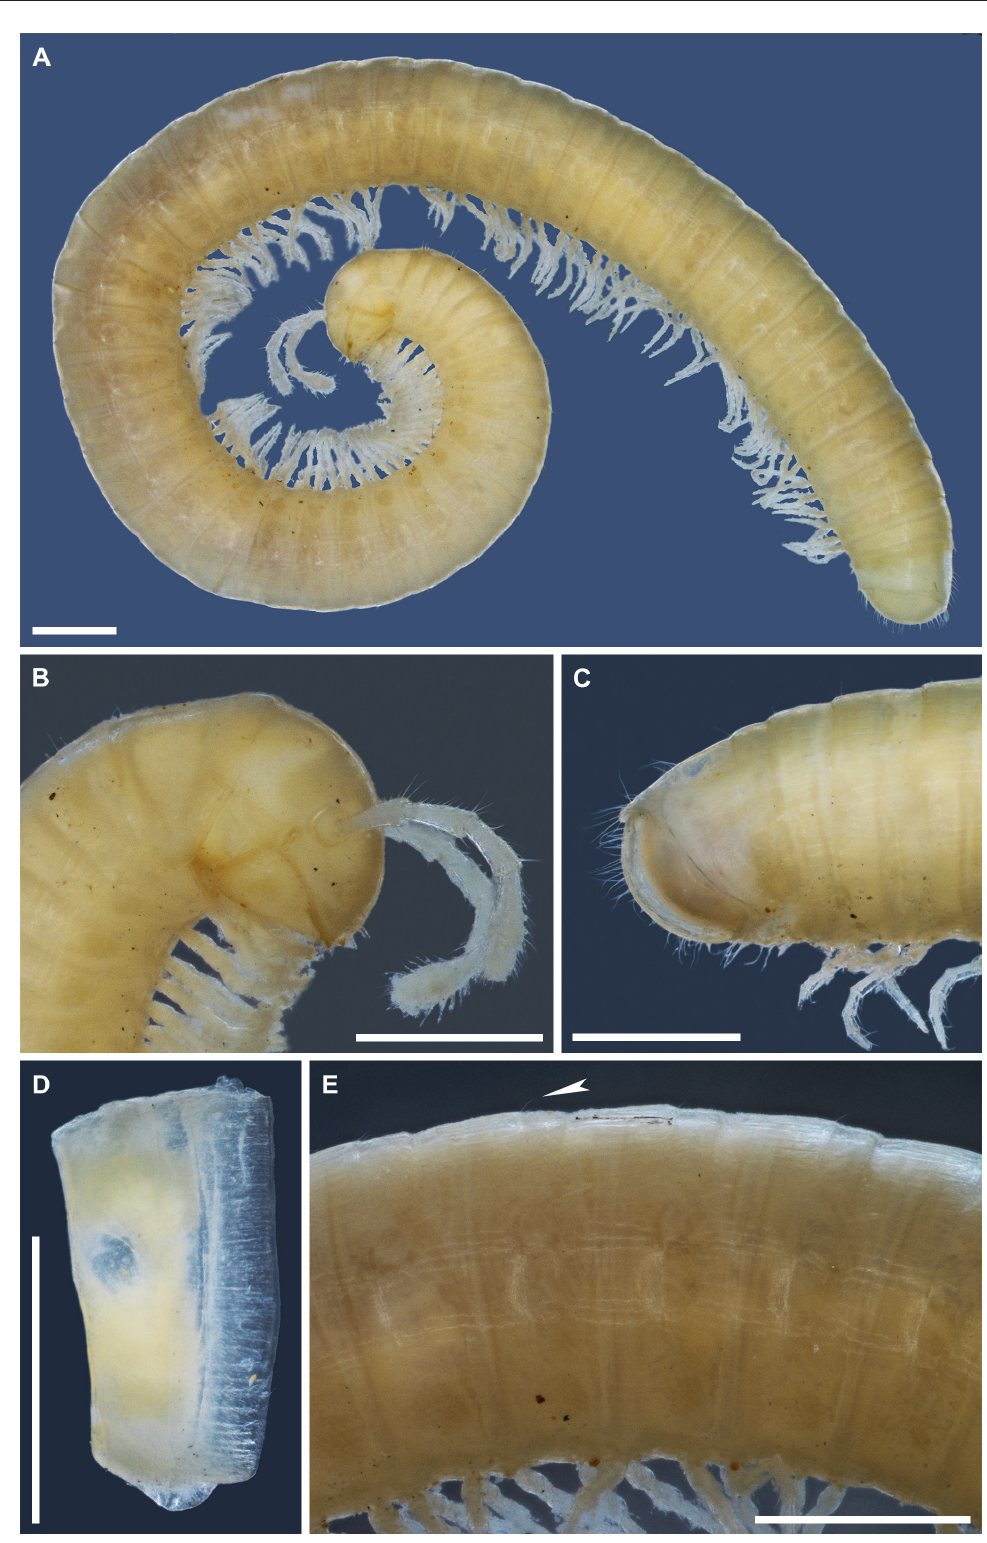
Fig. 16. Leucogeorgia borealis sp. nov., types from Fanagoriyskaya Cave (ZMUM). A . Paratype ♀, habitus, lateral view. B . Paratype ♀, anterior part of body, lateral view. C . Paratype ♂, posterior part of body, lateral view. D . Holotype ♂, body ring 7, lateral view. E . Paratype ♀, midbody rings, lateral view. Arrow indicated metazonal seta. Scale bars: 1